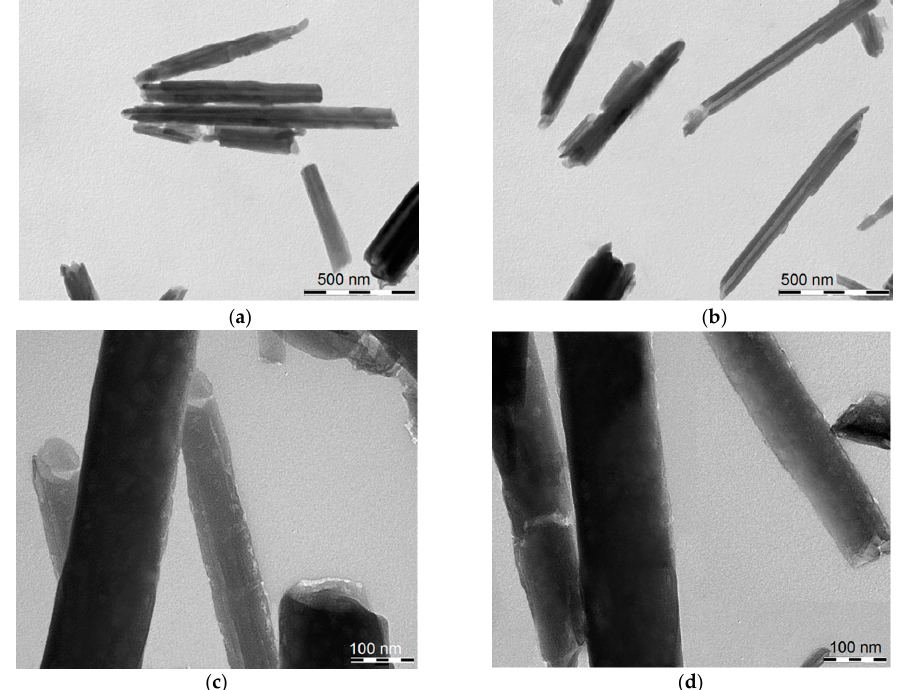
Figure 2. Transmission electronic microscopy (TEM) images of ( a , c ) pristine HNT; ( b , d ) of HNT/AH 2 showing the nanotubular structure. Scale bars: ( a , b ) 500 nm; and ( c , d ) 100 nm.